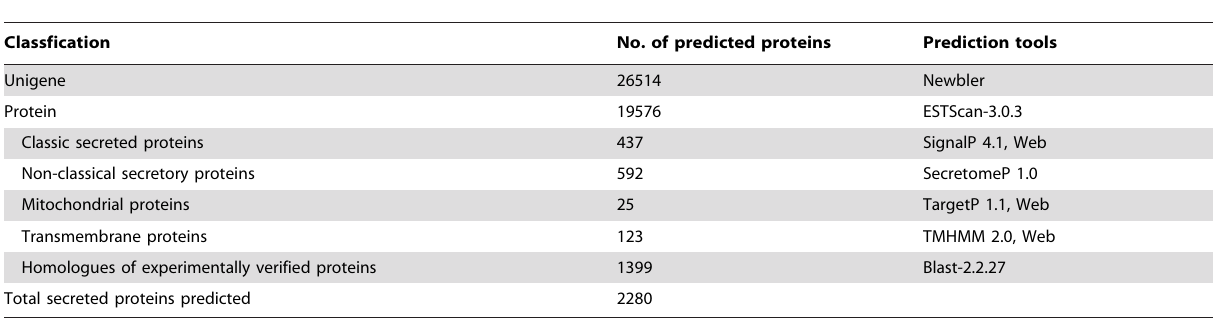
Table 2. Prediction of secretory-excretory proteins (ESP) from the transcriptome of